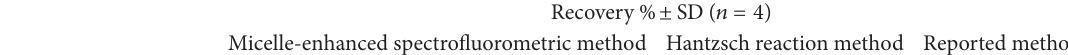
Table 4: Determination of GFX in its pharmaceutical dosage forms using the proposed methods. Dosage form